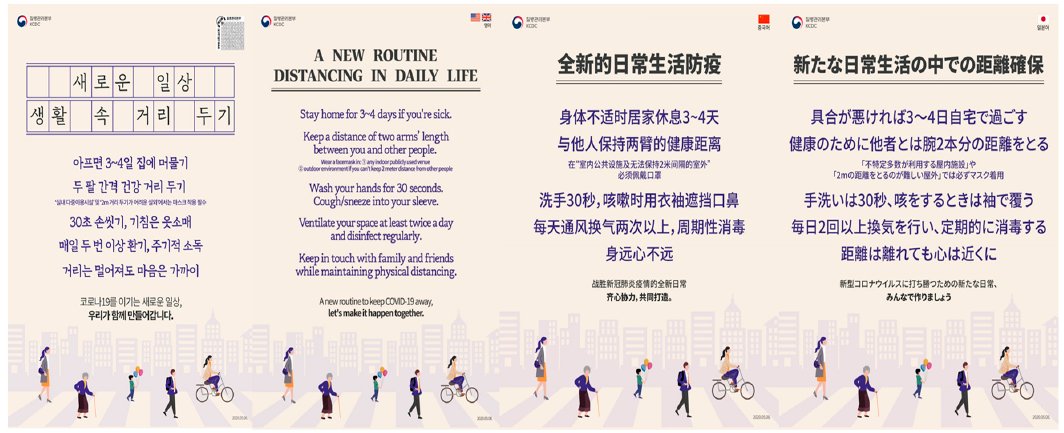
Figure 10. Routine Distancing Guideline.